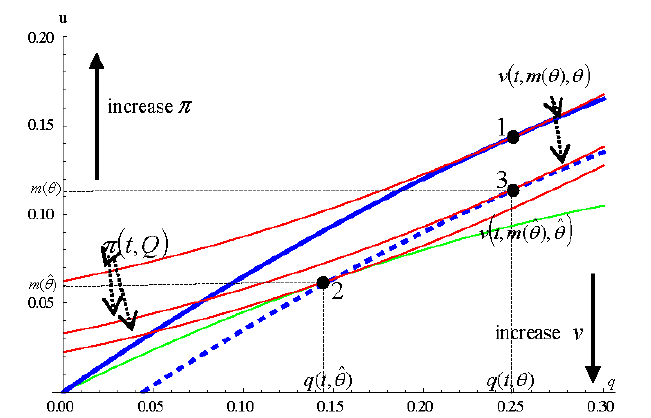
Figure 1. The formation of mixing and separating equilibria. Indifference curves of utility functions for a higher type consumer θ are shown in blue, and for a lower type consumer ˆ θ in green. Indifference curves of the supplier’s profit are shown in